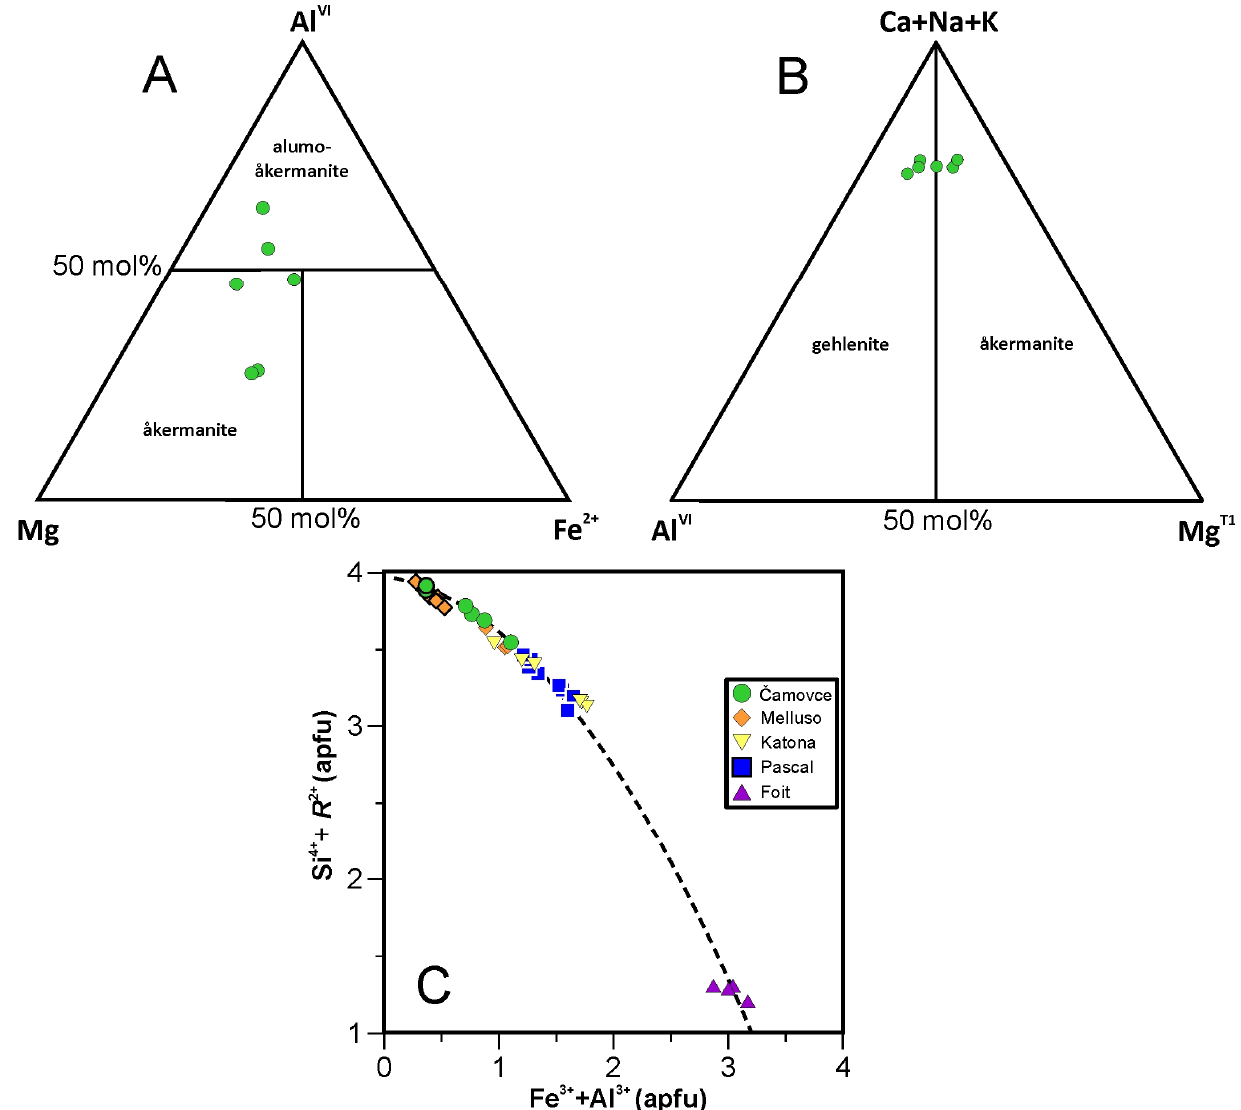
Figure 16. ( A , B ) Classification diagrams of melilite-group minerals from ˇCamovce; ( C ) Fe 3+ +Al 3+ versus Si 4+ + R 2+ diagram and comparison with literature data [2,44,45,47]. R 2+ denotes divalent cati ‐ ons.